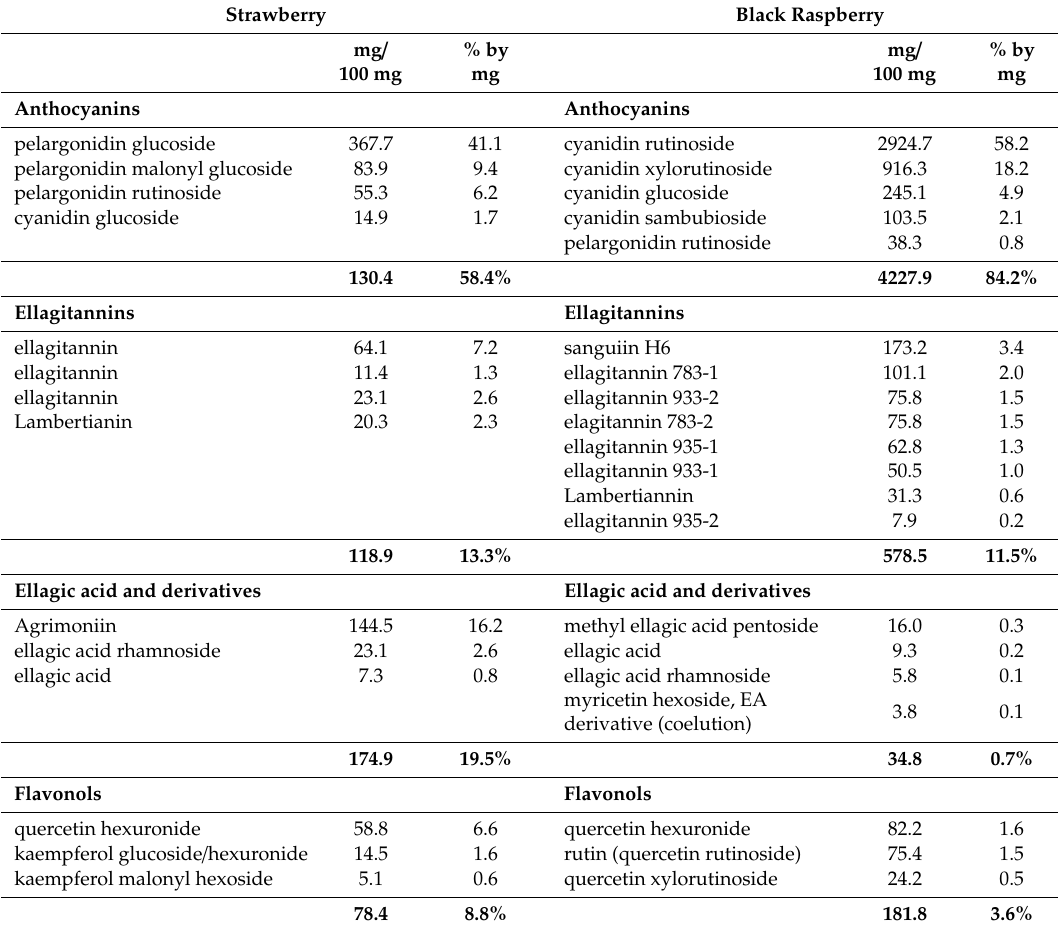
Table 2. Major components in strawberry and black